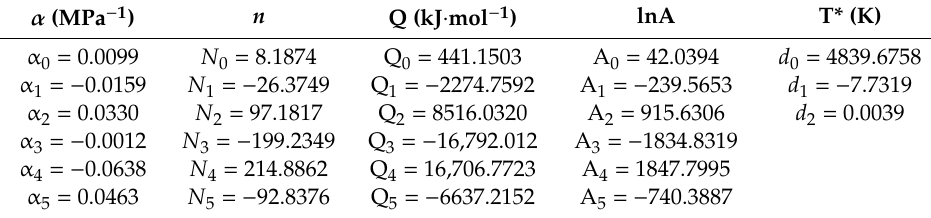
Figure 14. Relationship between the deformation temperatures and the equivalent temperatures in the msA-type equation. Table 3. Coefficients of the polynomial for α , n , Q and lnA in the msA-type equation.